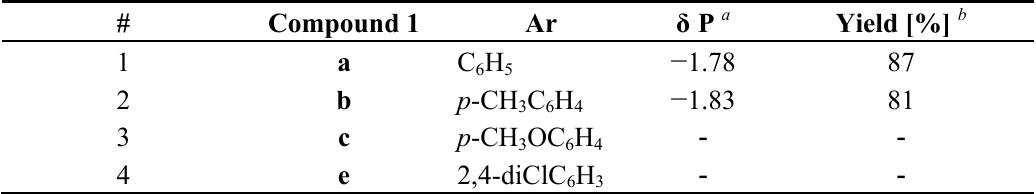
Table 2. Results of synthesis of chiral Brønsted acids having aromatic groups in the